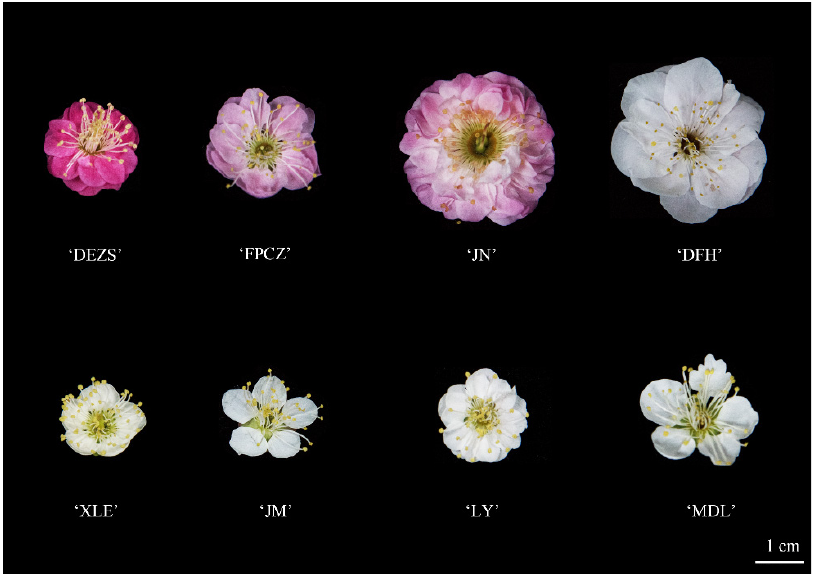
Figure 6. The flowers of eight P. mume cultivars with four scent